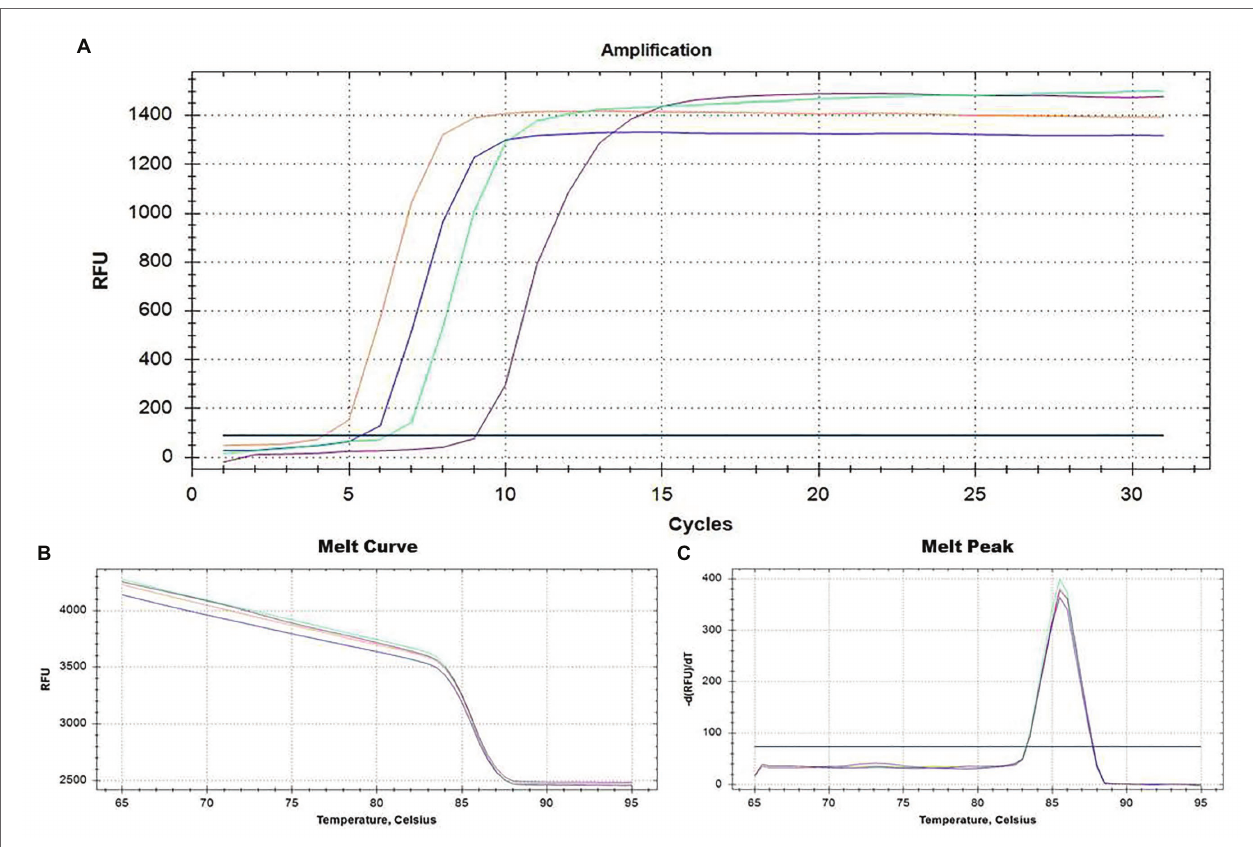
FIGURE 2 | Real-time monitoring of the RT-LAMP result assay for ToBRFV detection based on primer pairs designed on the 5 ' region of the RNA-dependent RNA polymerase gene ( RdRp ; Table 1 ). Amplification plots and the two dissociation curves, melting curve and melting peak, are shown in (A-C) , respectively. ToBRFV isolates used as positive controls, including Italian isolates Sic1/19 (blue curve) and T1101 (green curve), the Palestinian isolate TBRFV-Ps1 (purple curve), and the German isolate PC-1236 (orange curve). Negative controls (black line) consisted of a no-template control (NTC). Healthy tomato plants and other different tobamoviruses (see section “Virus isolates and plant material”) were also used as negative controls (not